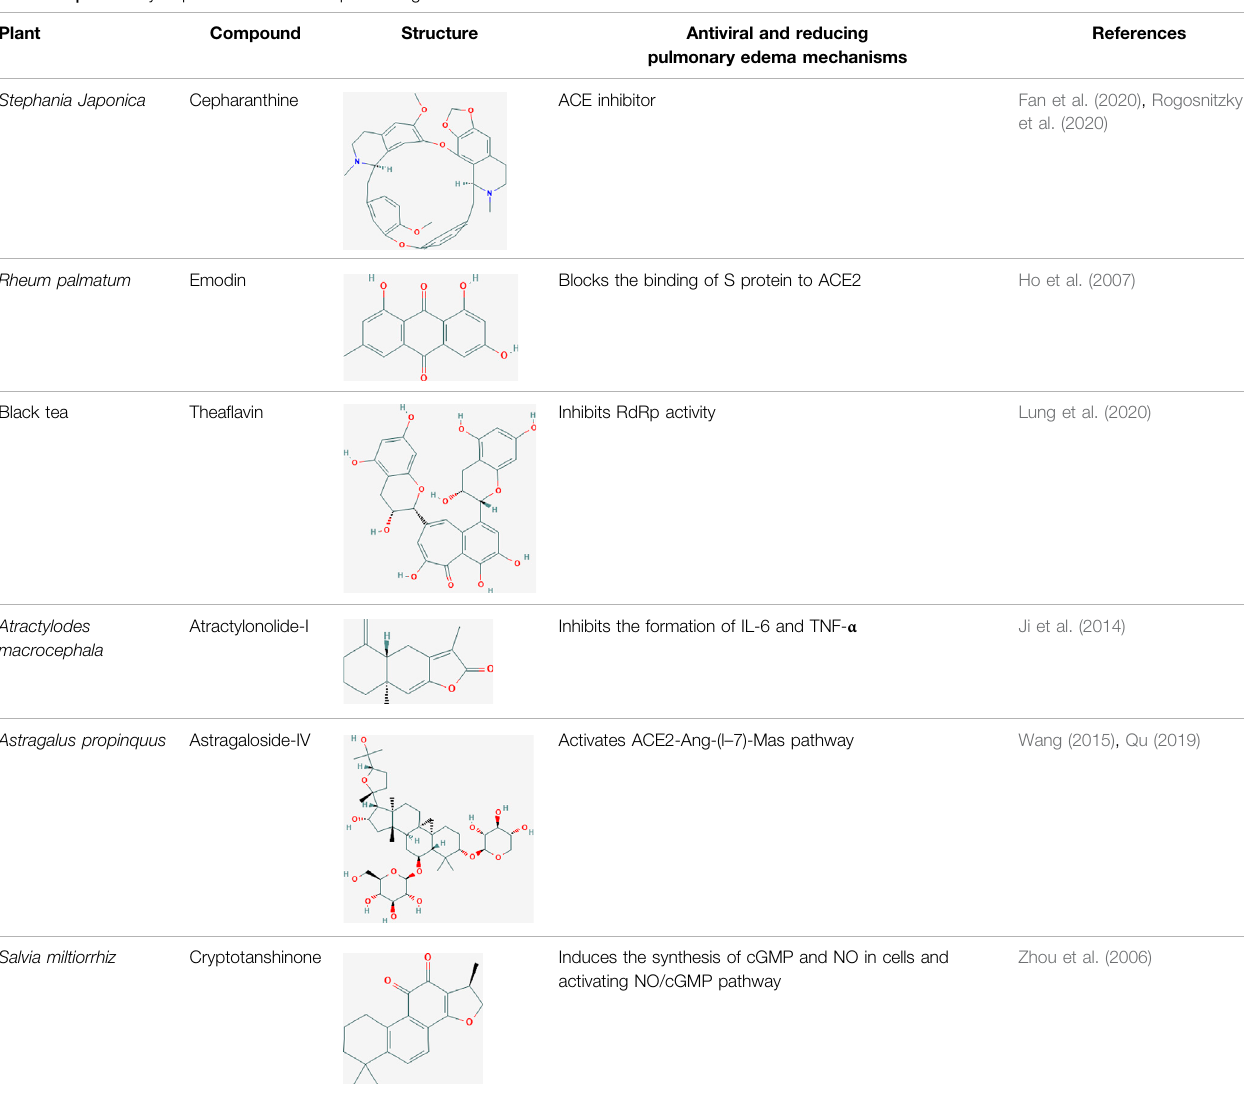
TABLE 2 | Summary of potential natural compounds against